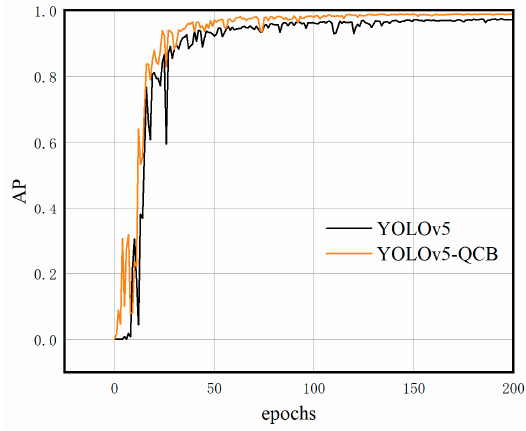
Figure 11. AP curve for network model training.